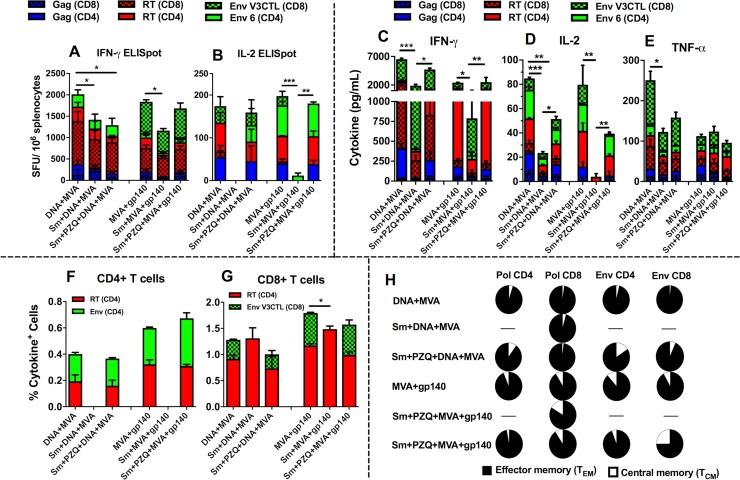
Sm infection alters vaccine-specific cellular responses and treatment with PZQ only partially restores these responses close to normal.Mice were chronically infected with Sm before vaccination with a DNA-vectored and MVA-vectored HIV-1 (DNA+MVA) vaccine or an MVA-vectored HIV-1 and a HIV-1 gp140 Env protein (MVA+gp140) vaccine regimen with or without prior anti-helminthic treatment with PZQ. Spleens were collected 12 days after the last vaccination. The splenocytes were stimulated and the induced cytokines measured in an IFN-γ (A) and IL-2 (B) ELISpot, cytometric bead array (C, D, and E), and intracellular cytokine staining (F, G, and H) assays. Results represent 3 independent experiments and plotted as the mean + SEM. Statistical analysis was performed using unpaired, two-tailed t-test analysis followed by FDR for multiple comparisons. (*: p<0.05; **: p<0.01; ***: p<0.001).